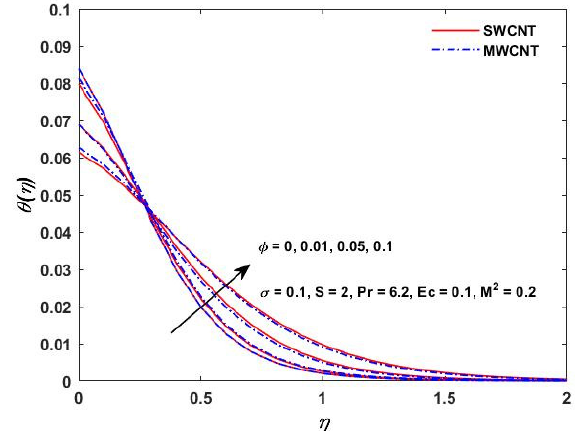
Figure 9. Solid volume 𝜙 verses 𝜃(𝜂).